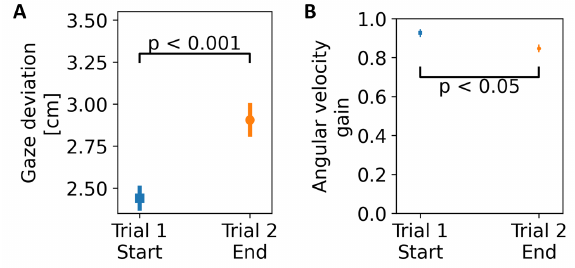
Figure 6. Eye movement metrics as a function of the time-on- task – (A) marginal gaze deviation and (B) marginal angular velocity gain. Error bars indicate standard